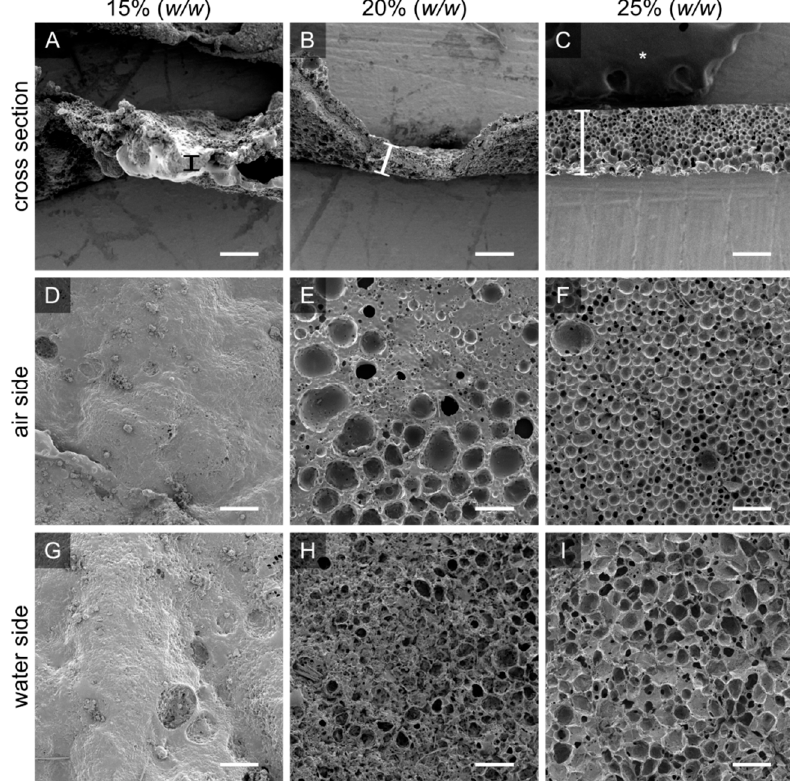
Figure 2. The initial PTMC-dMA concentration is crucial for homogenous porous scaffold formation. Scanning electron micrographs are shown for PTMC-dMA scaffolds prepared at room temperature for ten minutes with three PTMC-dMA concentrations. The top panels ( A – C ) show the cross sections with the air side facing upwards. The thickness is indicated by a vertical bar. The middle panels ( D – F ) show the air side, and the bottom panels ( G – I ) show the water side of the scaffolds. Scale bars are 200 μ m. The asterisk (*) indicates the carbon tape used to stick the samples to the SEM stub.